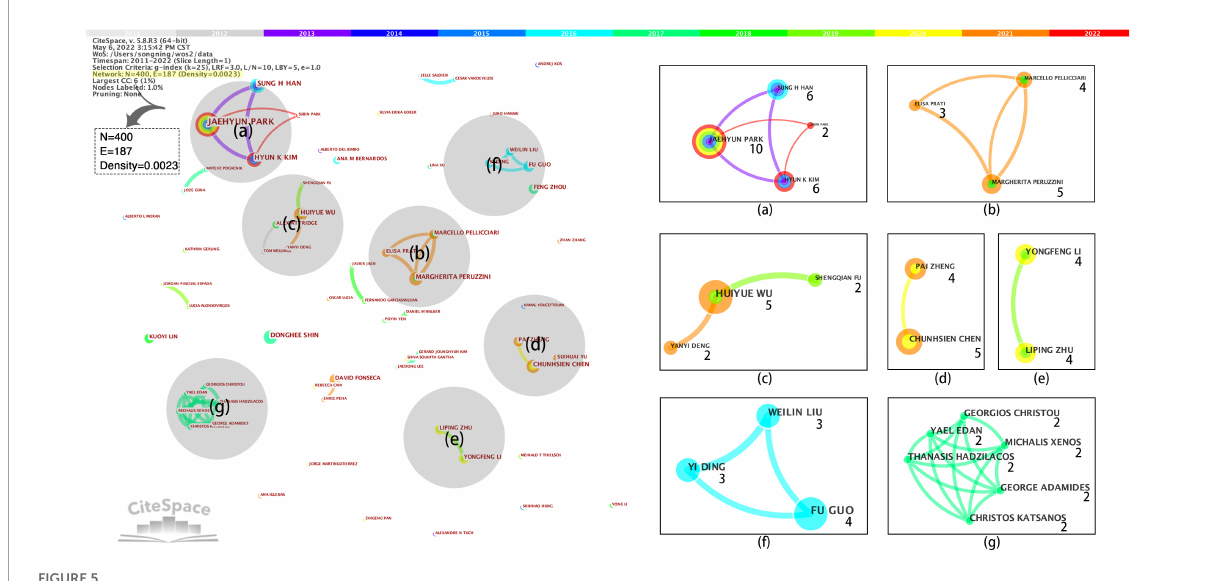
FIGURE5 Core author network